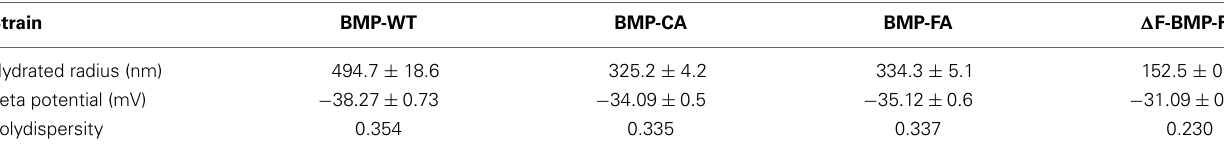
Table 3 | Particle size and zeta potential of magnetosomes from various